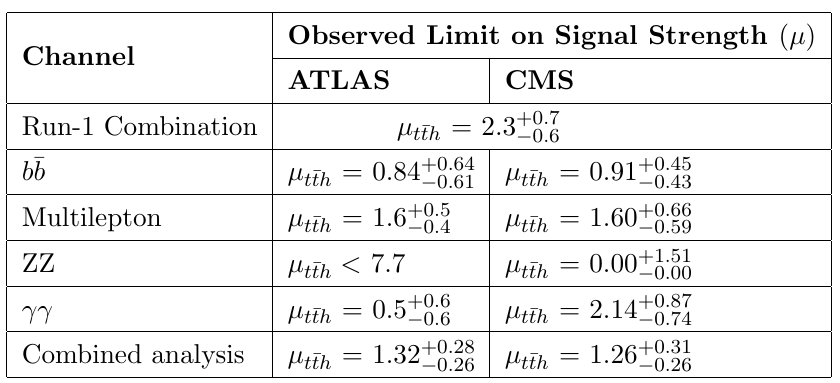
Table 4 . Current summary of the observed signal strength (cid:22) measurements and t (cid:22) th production signi(cid:12)cance from individual analyses and the combination as reported by ATLAS and CMS collab- oration